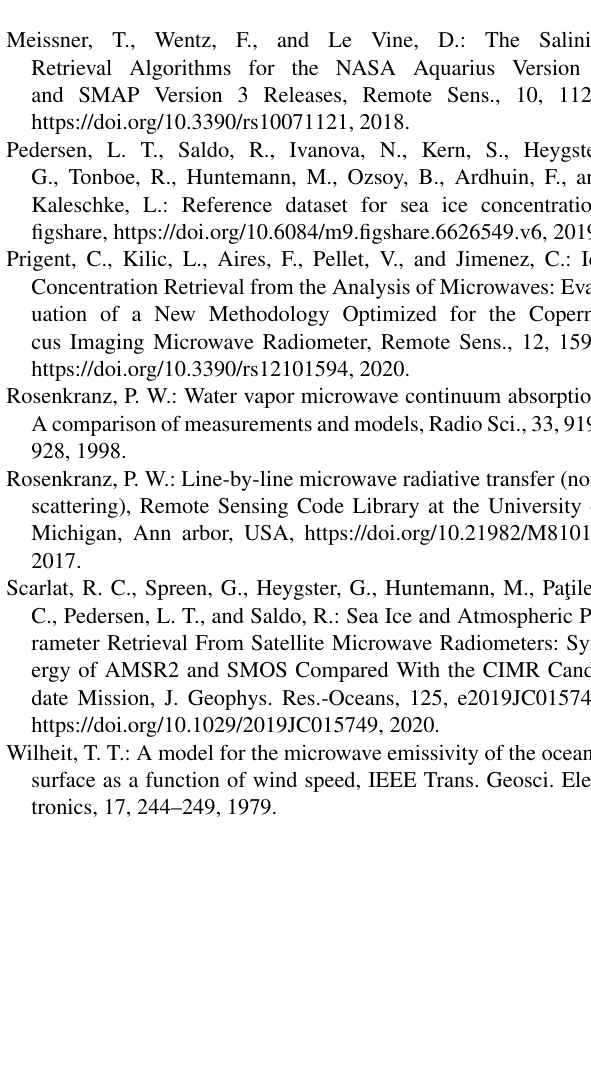
figshare, https://doi.org/10.6084/m9.figshare.6626549.v6,